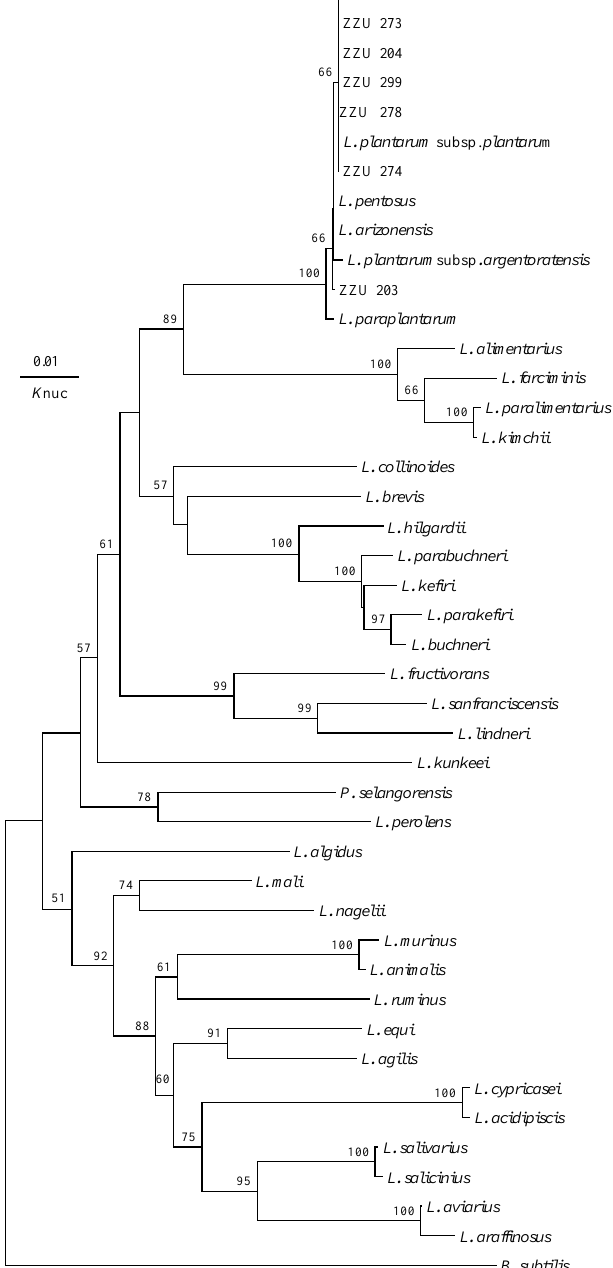
Figure 1. Phylogenetic tree showing the relative position of Lactobacillus plantarum as inferred by the neighbor-joining method with 16S rRNA gene sequences. Bootstrap values for a total of 1,000 replicates are shown at the nodes of the tree. Bacillus subtilis is used as an outgroup. The bar indicates 1% sequence divergence. K nuc, nucleotide substitution